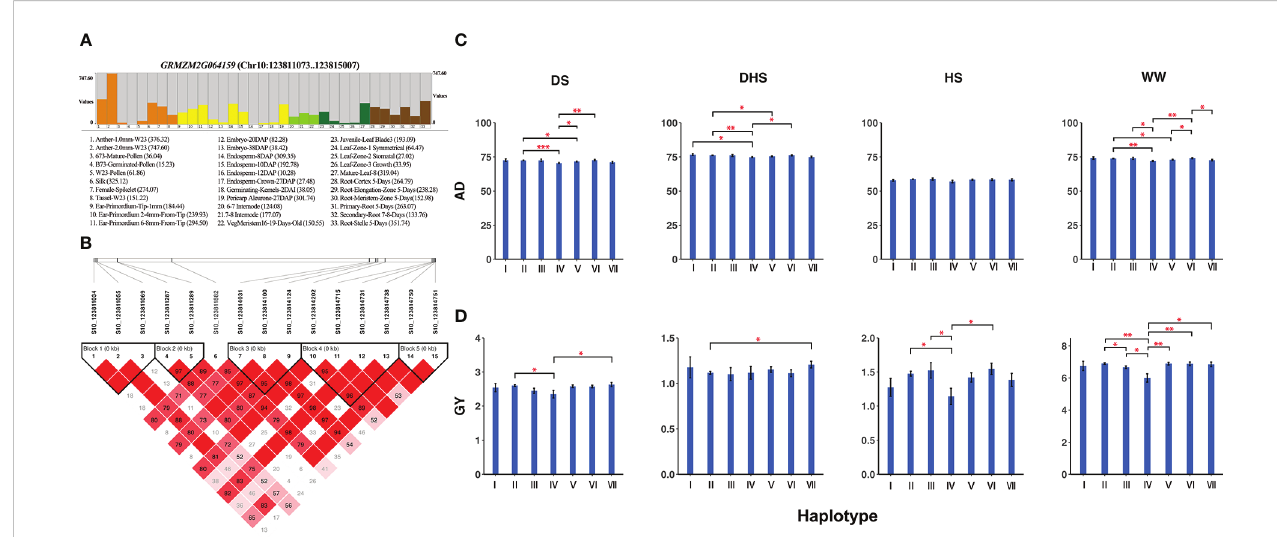
FIGURE 5 (A) Tissue-speci fi c expression pro fi le, (B) Linkage disequilibrium, and haplotype block with 14 SNPs inside for the candidate gene GRMZM2G064159. (C) Comparison of trait AD among haplotypes I (AACGCAACAGGACA), II (AACGCAGCGCCGCT), III (AACGCAGCGGCATA), IV (AAGGCAGCGCCGCT), V (AAGGCAGCGGCATA), VI (GCGGCAACAGGACA) and VII (GCGGCAGCGCCGCT). (D) Comparison of trait GY among haplotypes I, II, III, IV, V, VI, and VII. The number of stars represents the result of t test at different signi fi cance levels (*:0.05; **:0.01;